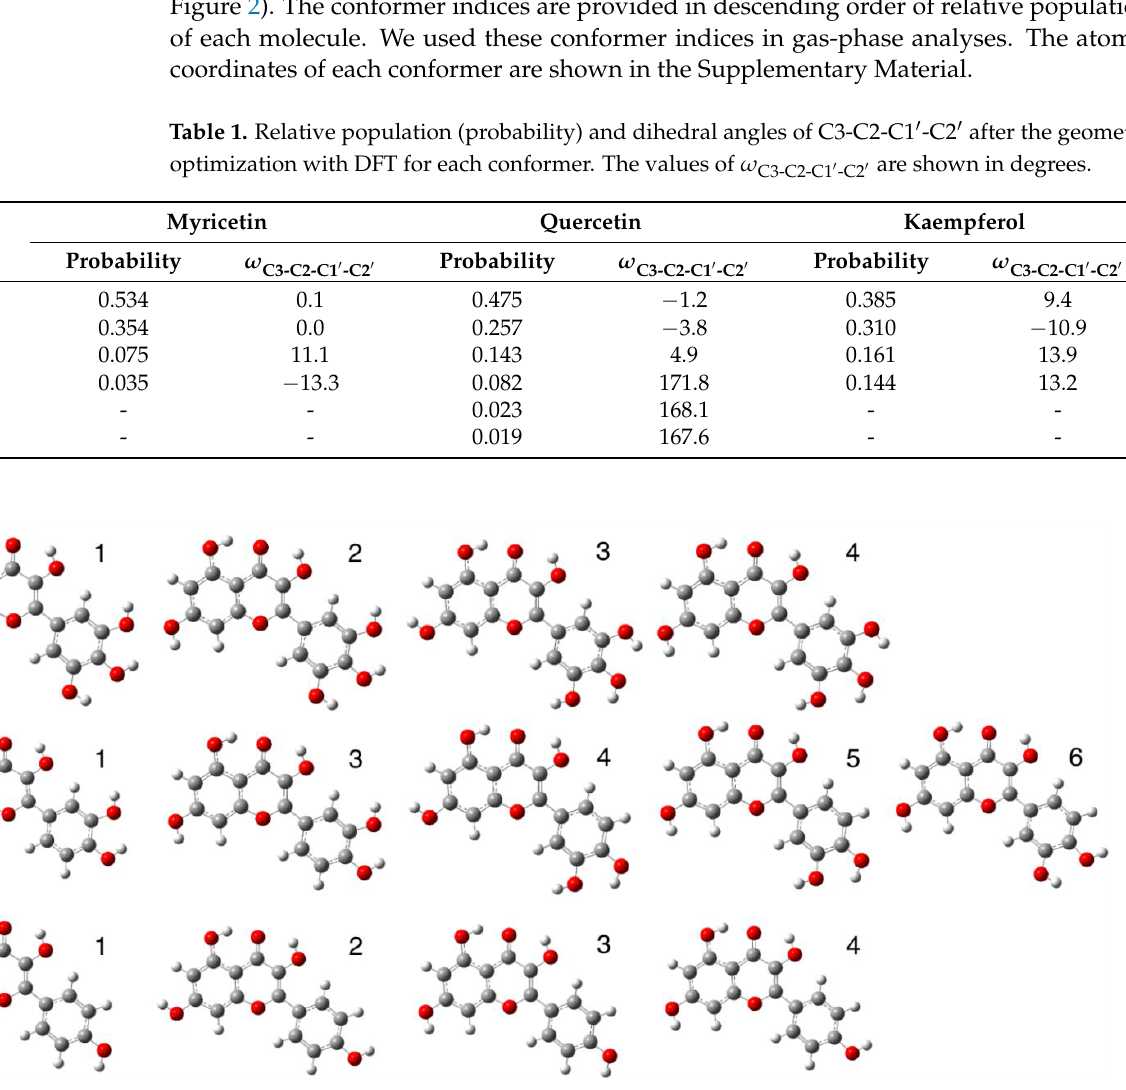
Figure 2. Conformers obtained by geometry optimization with DFT in the gas phase for ( a ) myricetin, ( b ) quercetin, and ( c ) kaempferol. Numbers in the upper right for each molecule represent their conformer indices. For quercetin, conformer 2 is omitted because the orientation of the hydrogen atom in the hydroxy groups of the conformer 2 is the same as that of conformer 1.